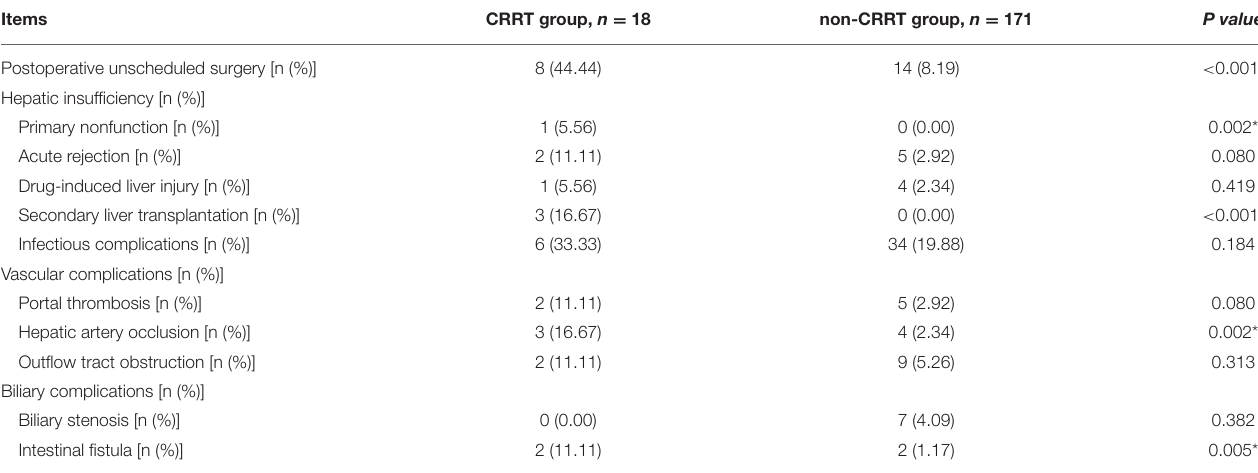
TABLE 2 | Comparison of the postoperative complications in pediatric patients with acute kidney injury after liver transplantation.